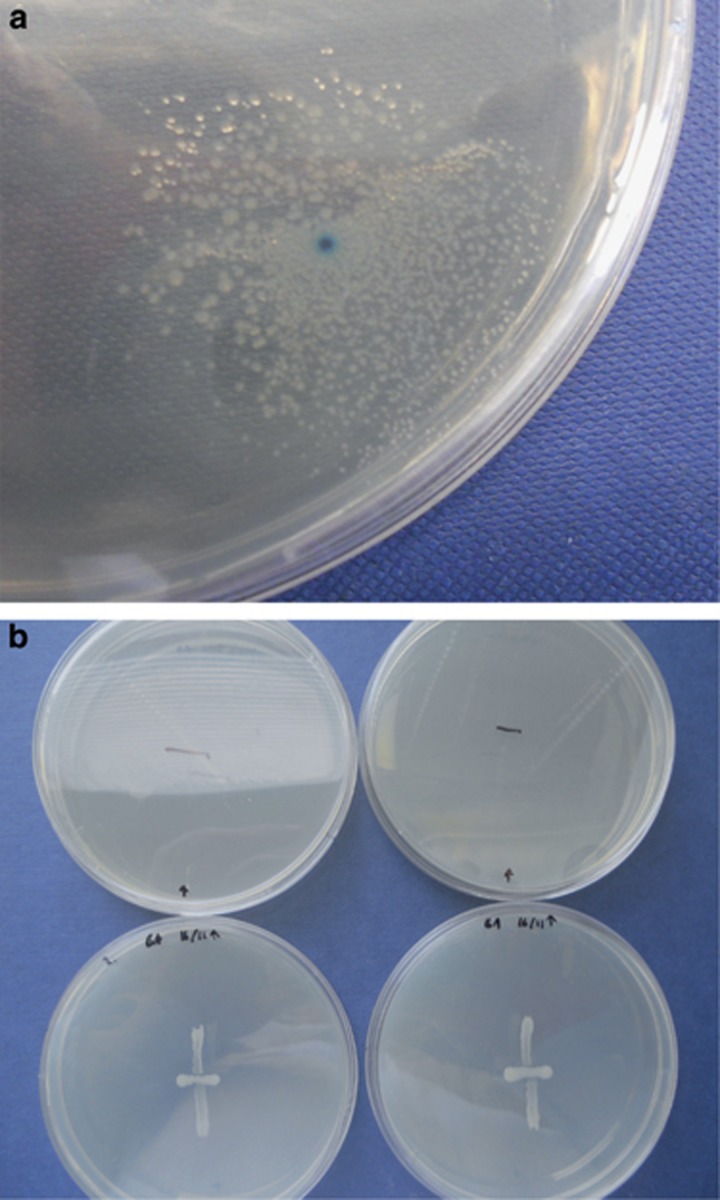
(a) Satellite colonies around a successful pUC19 transformant on ampicillin agar. Transformation of E. coli DH10B with pUC19 confers resistance to ampicillin and also restores the lac operon, resulting in a blue colony on agar containing X-Gal and IPTG. The successful transformants appeared after ~16 h, white susceptible colonies appeared after >24 h incubation and can be seen growing around the resistant transformants. (b) Antibiotic clearance bioassay. Susceptible colonies grow on ampicillin plates in the presence of resistant colonies (bottom row), but not alone (top row). Resistant colonies were incubated for 48 h on 100 μg ml−1 ampicillin plates before the addition of susceptible colonies. Susceptible strains can grow in the region around the resistant colony, but do not grow outside the central zone or in the absence of a resistant colony (top row). These assays were repeated seven times.